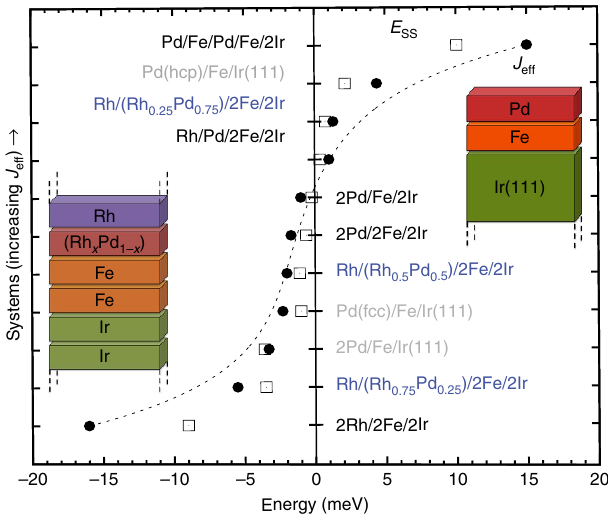
Figure 1 | Effective exchange interaction in multilayers. J eff (full circles) is given for TM multilayers (black/blue fonts) and ultra-thin films on surfaces (grey fonts). Insets show sketches of the multilayer and thin film geometry. The energy difference between a spin spiral with a wavelength of 2.7nm with respect to the FM state, E SS , is given by empty squares. The dashed line is a guide for the